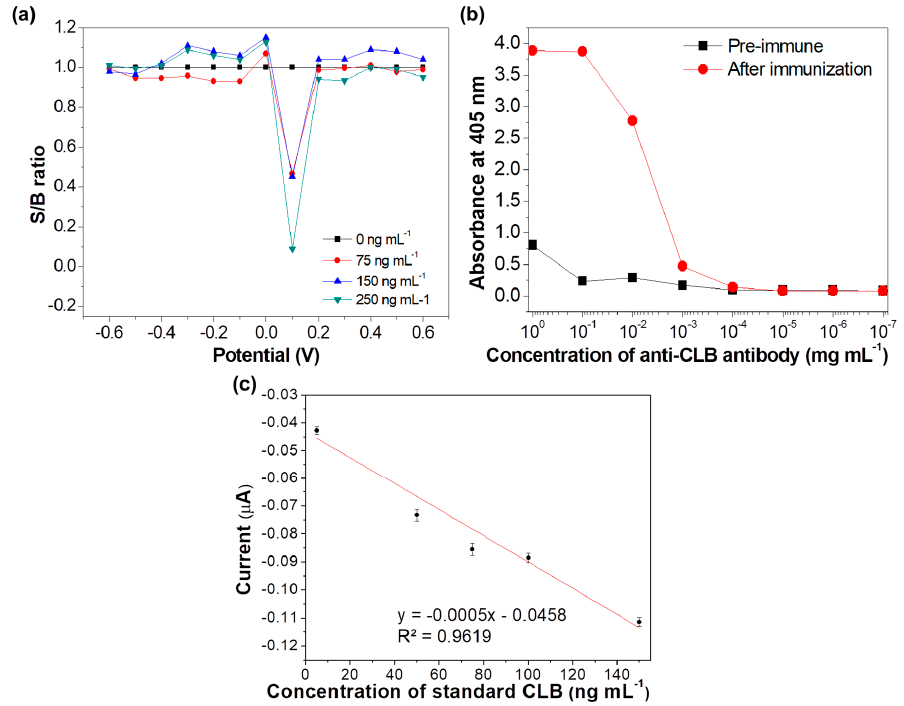
Figure 4. ( a ) Plot signal to background (S/B) for each step potential from − 0.6 to 0.6 V